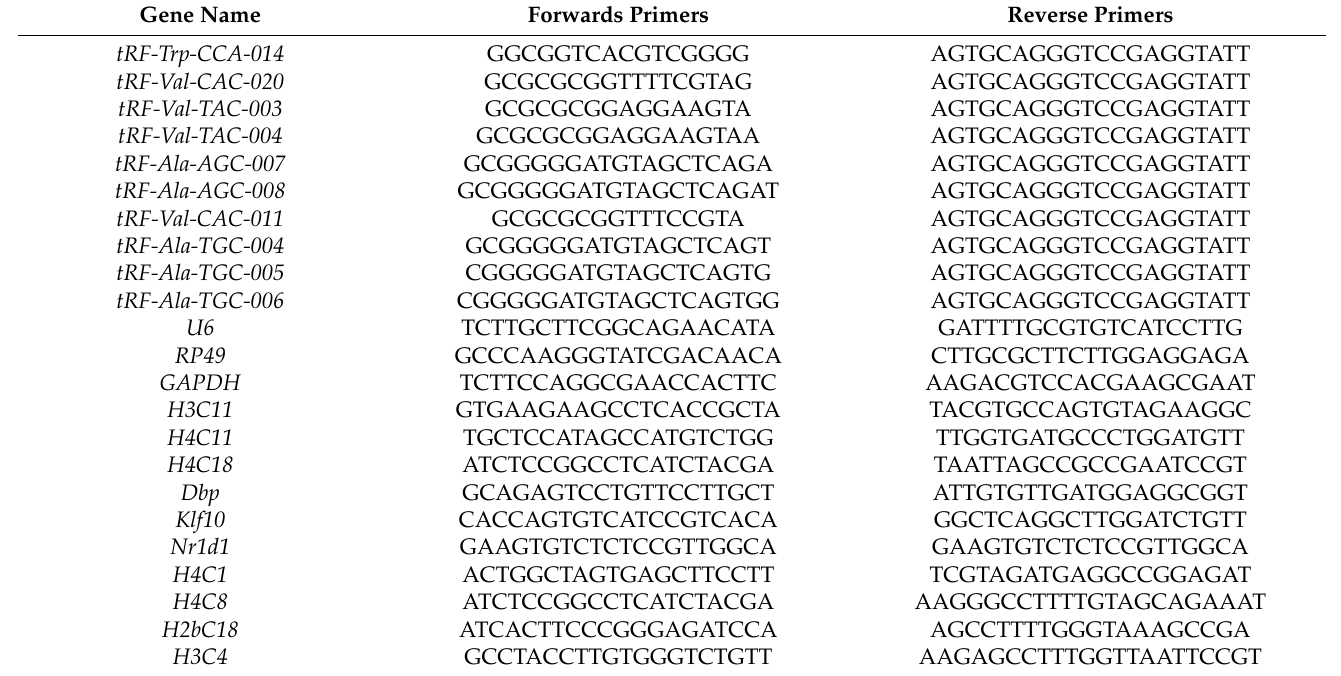
Table 1. Primer sequences for real-time quantitative PCR